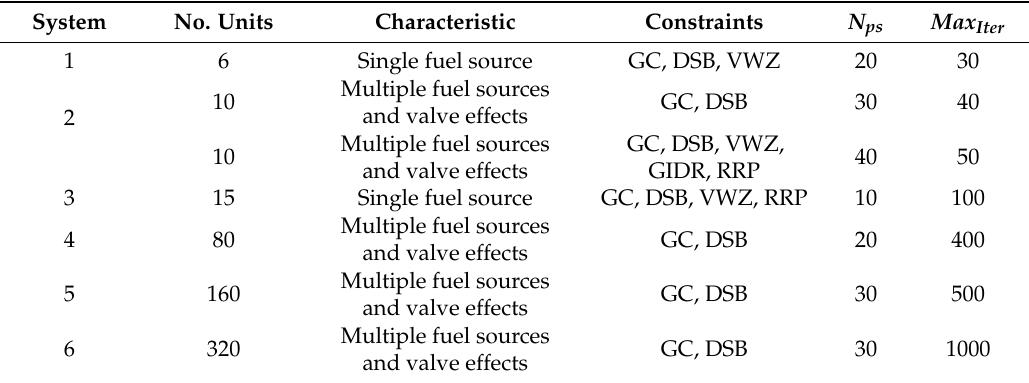
Table 1. The selection of population size and the highest iteration